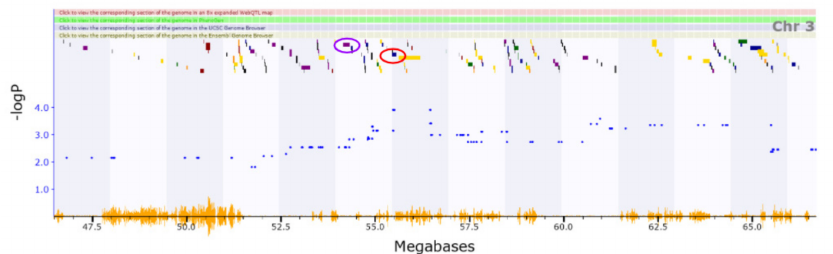
Figure 2. (55.52 Mb) shown in the red circle, and Trpc4 shown in the purple circle (54.27 Mb), which both have cis-eQTLs in this region. Although these genes have not been annotated for this specific phenotype, they are implicated in previous studies with associated